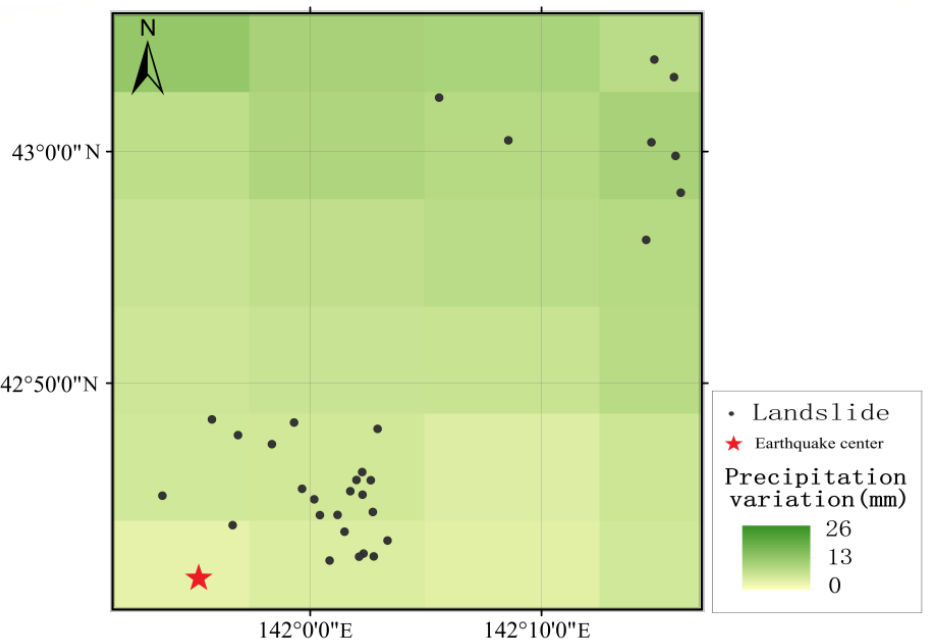
Figure 15. The spatial variation of rainfall before and after the earthquake and the distribution of slow-moving landslides after the earthquake.